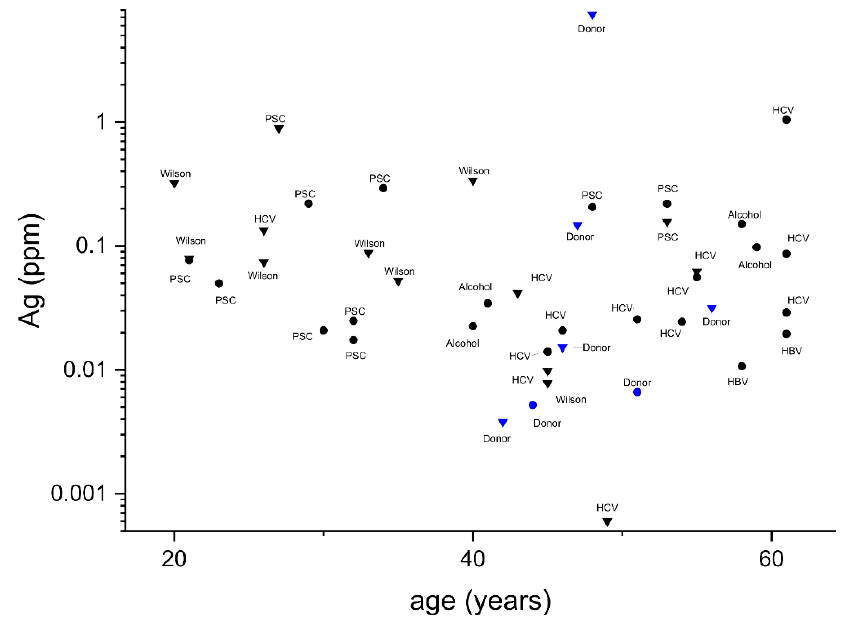
Figure 4. The plot of silver concentrations in livers of study subjects versus age, with their disease status and gender (triangles—male; circles—female) labeled in the plot. Individuals with silver levels below the detection limit were not included in the plot. No correlation between these parameters was found (see Table 1 for details).